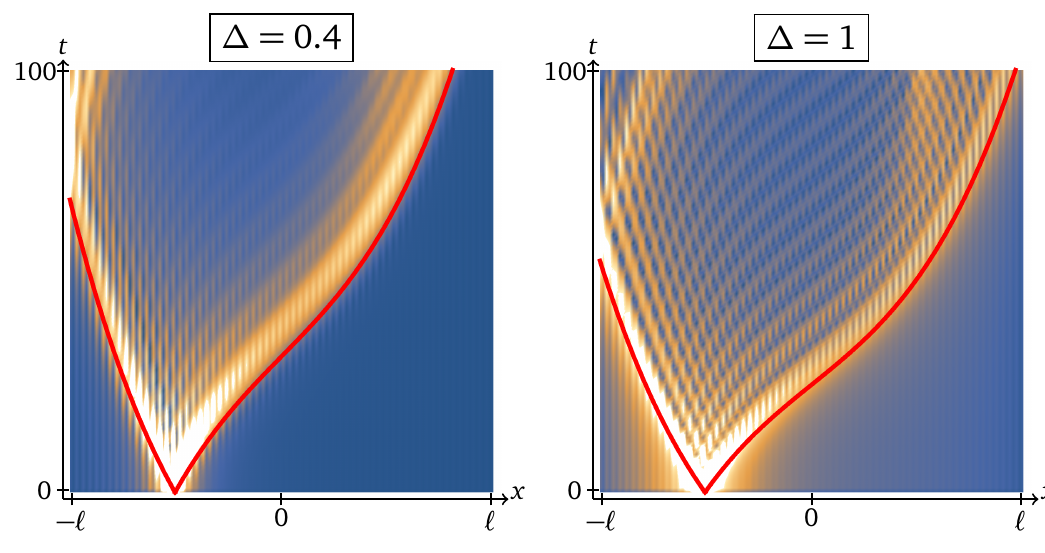
( t ) 〉 , for x = − (cid:96)/ 2 as a function of S 3 0 x 0 x